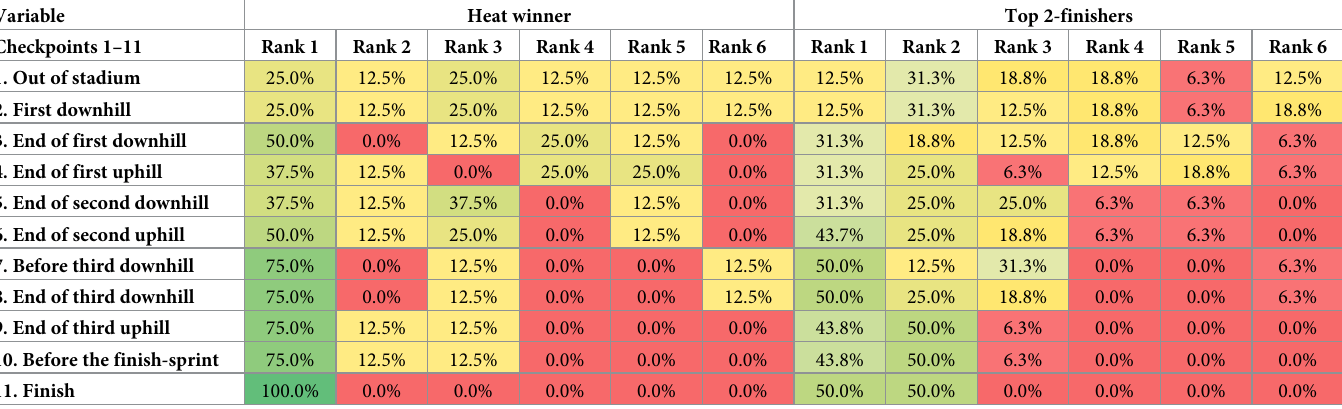
Table 2. Percentage of heat winners (left part) and top-two finishers (right part) positioned at rank 1–6 at the 11 checkpoints during the heats of a 1.7-km classical sprint cross-country skiing race for elite male skiers. Presented as percentages [N = 16]. Variable Heat winner Top 2-finishers Checkpoints